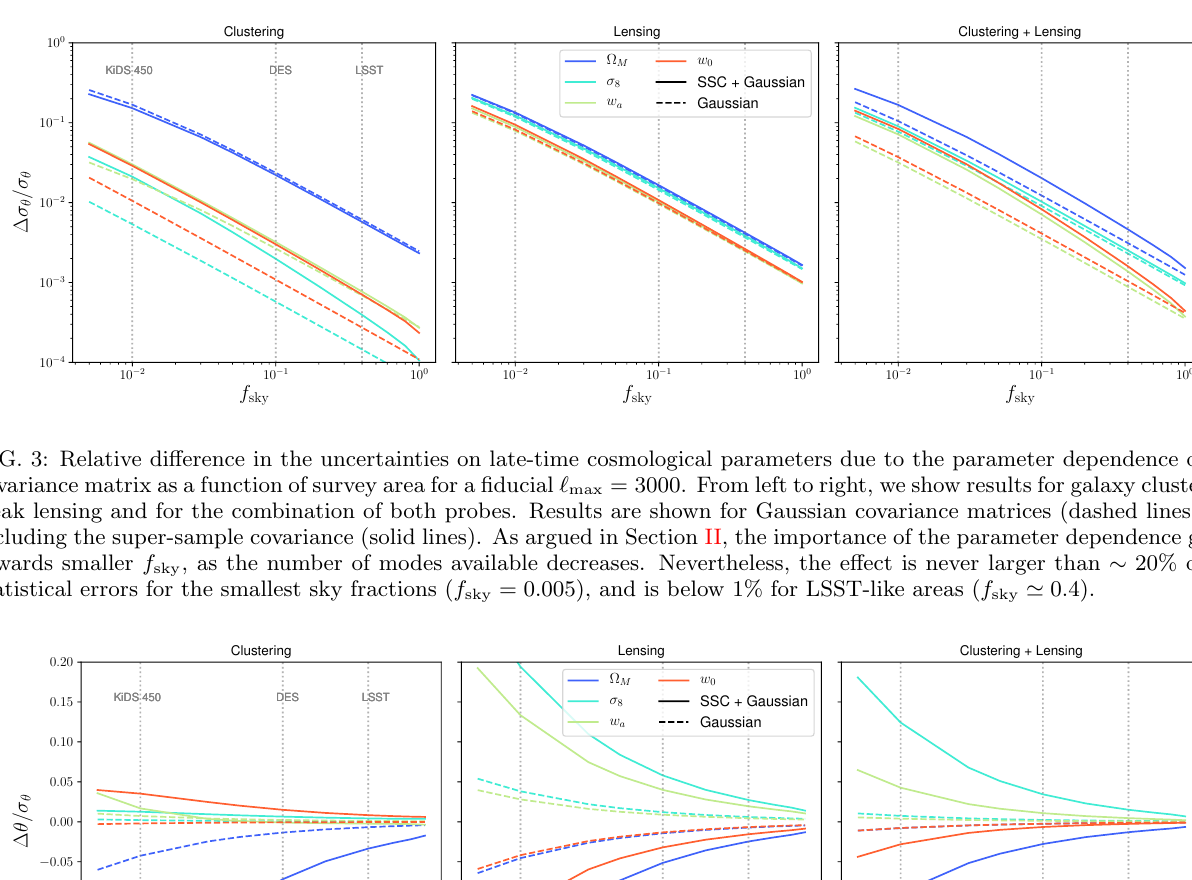
− 0 . 20 10 − 2 10 − 1 10 0 f sky FIG. 4: Same as Fig. 3 for the relative parameter bias. The effects of a parameter-dependent covariance are always smaller than 30% of the statistical uncertainties for the smallest sky areas ( areas ( f sky 0 . (cid:39)